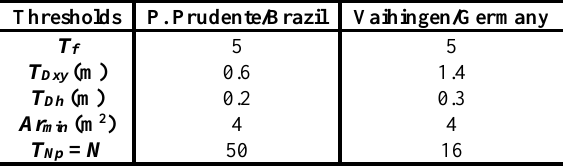
Table 2. Thresholds values considered in each dataset.